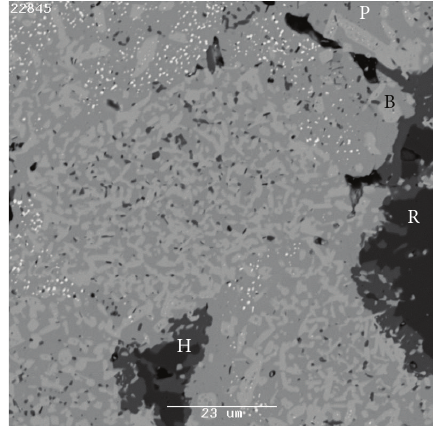
Figure 4: Microstructure of a baseline waste form designed to immobilise U-rich legacy waste at ANSTO. B = brannerite, H = hollandite, P = pyrochlore, R =